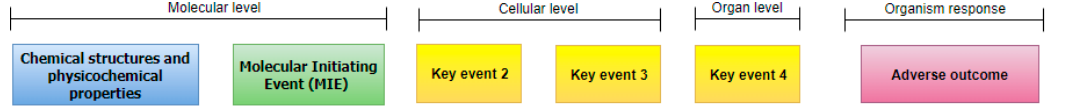
Figure 1. Representation of an Adverse Outcome Pathway (AOP) and its modular components.